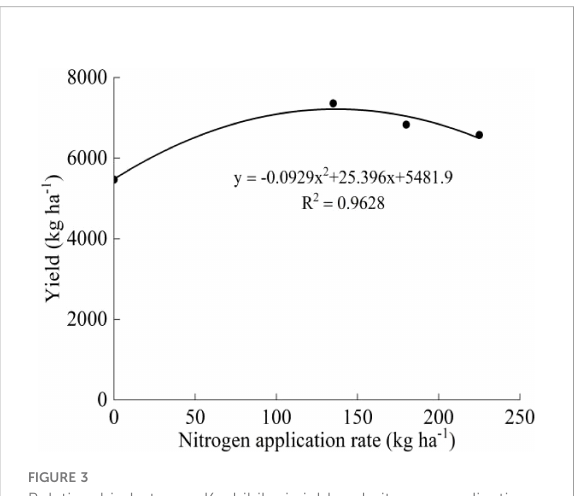
FIGURE 3 Relationship between Koshihikari yield and nitrogen application rate.